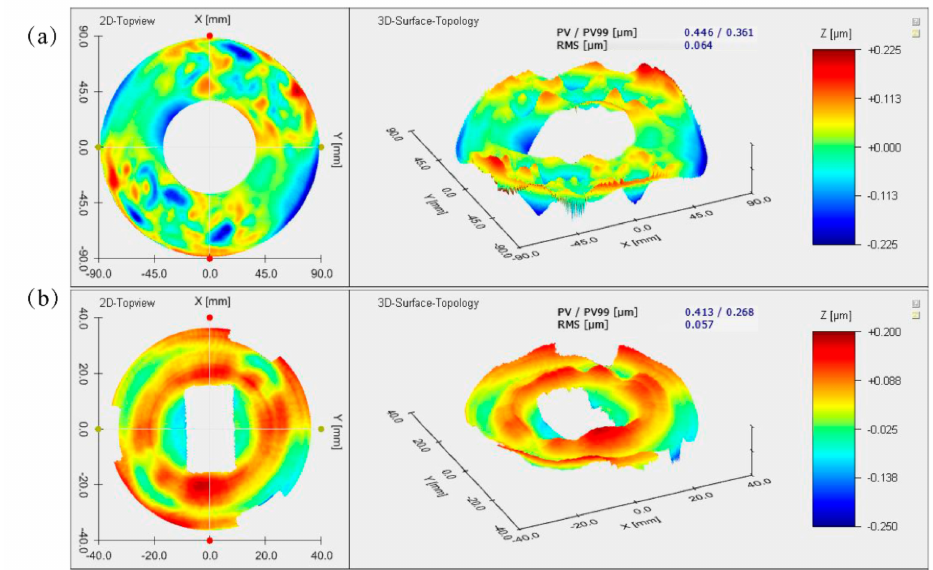
Figure 16. Surface shape deviation after polishing: ( a ) PM; ( b )